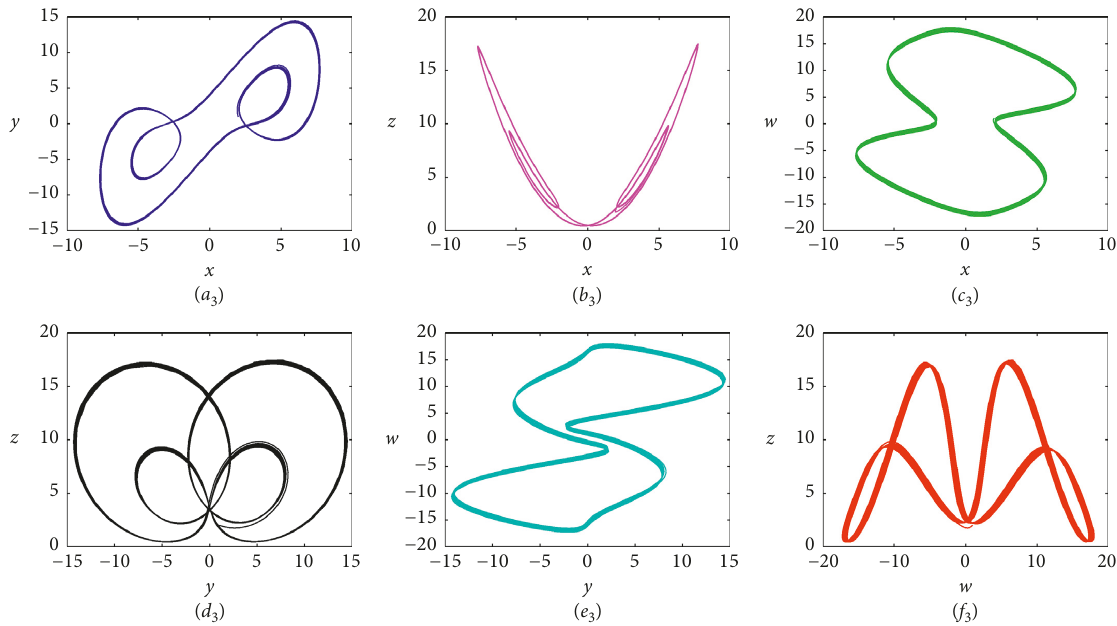
Figure 3: Phase portraits of Experiment 1 with a � 2 ,b � 1 , t � 1000: ( a y − z plane; ( e